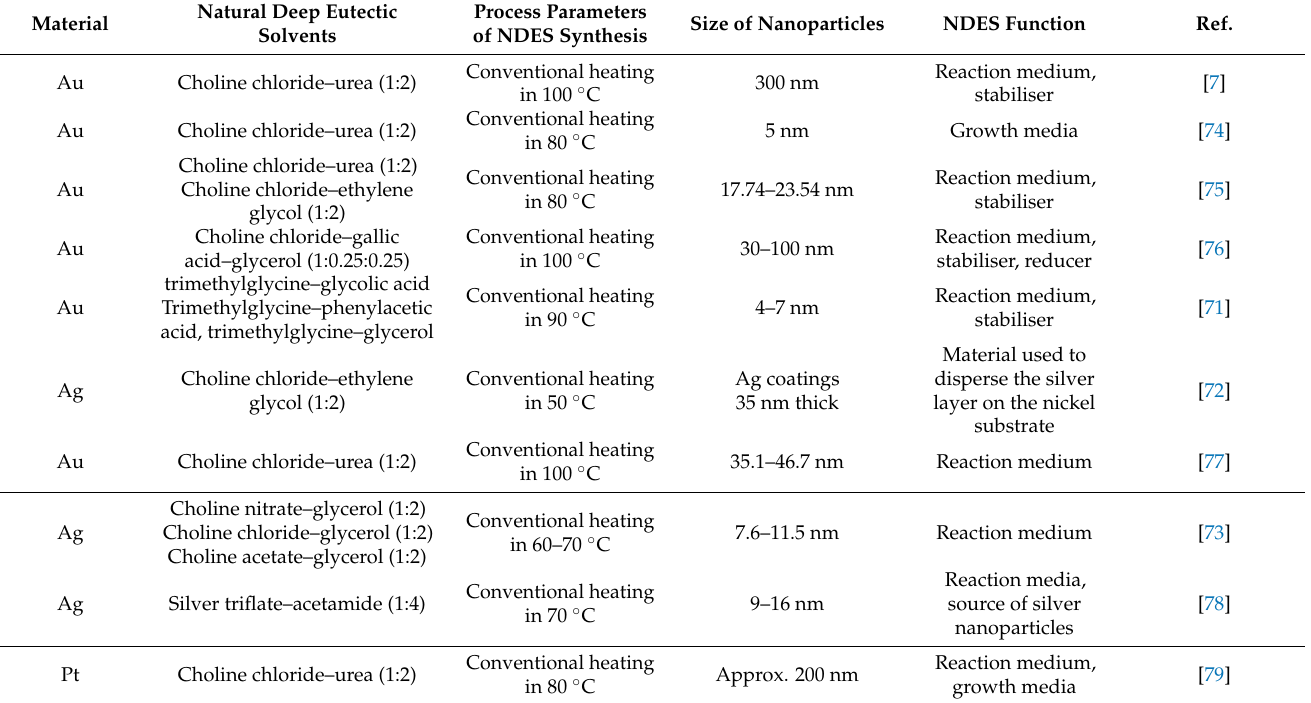
Table 2. Metal nanoparticles obtained using NDESs with a description of the method of obtaining NDESs and the functions it performs in the